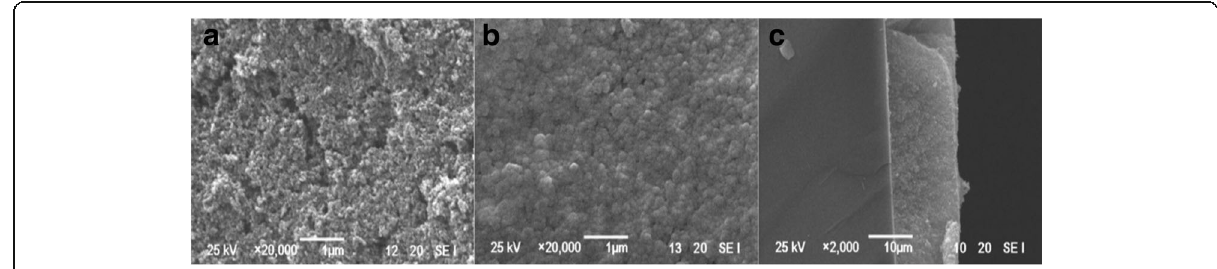
Fig. 4 SEM images of a P25 film, b 1 wt% graphite-P25 composite film, and ( c ) the cross section of P25 film on FTO